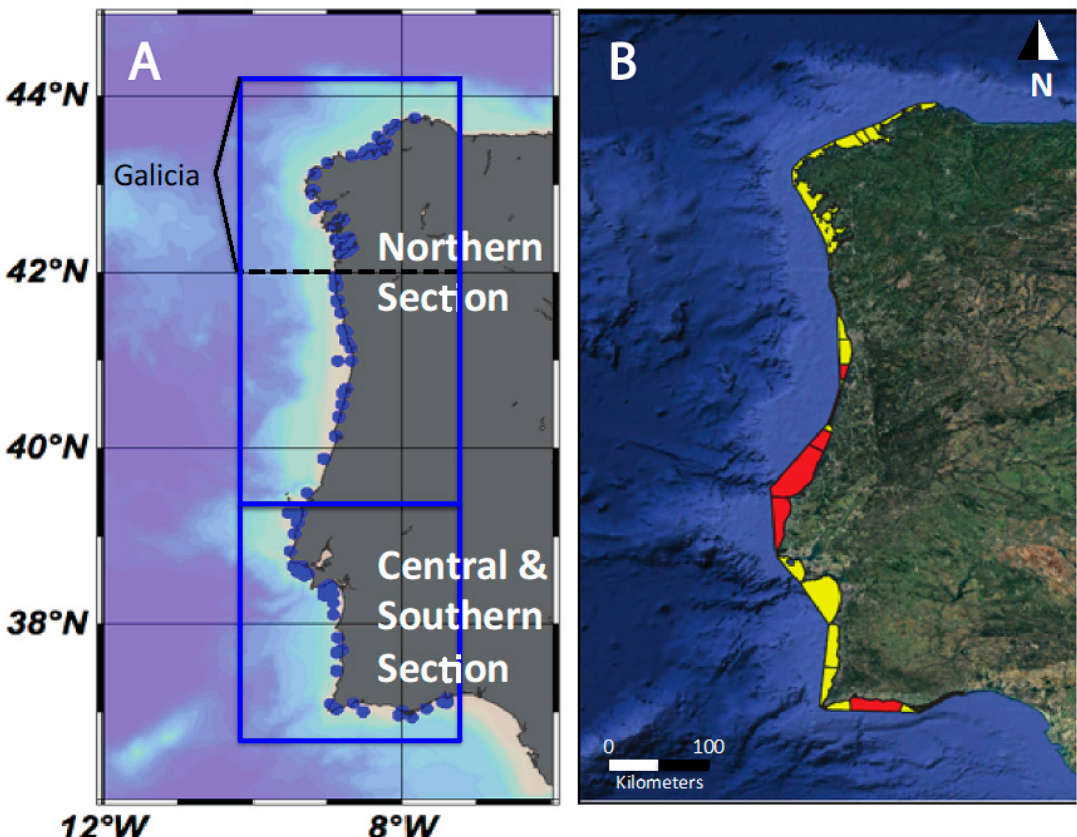
Figure 2. Location of sampling stations ( A ) and coastal water bodies (CWBs) of the NEA 1 / 26e typology ( B ). CWBs highlighted in red were identified as having insu ffi cient chlorophyll a (Chl a ) data. Water 2020 , 12 , x FOR PEER REVIEW 6 of 24